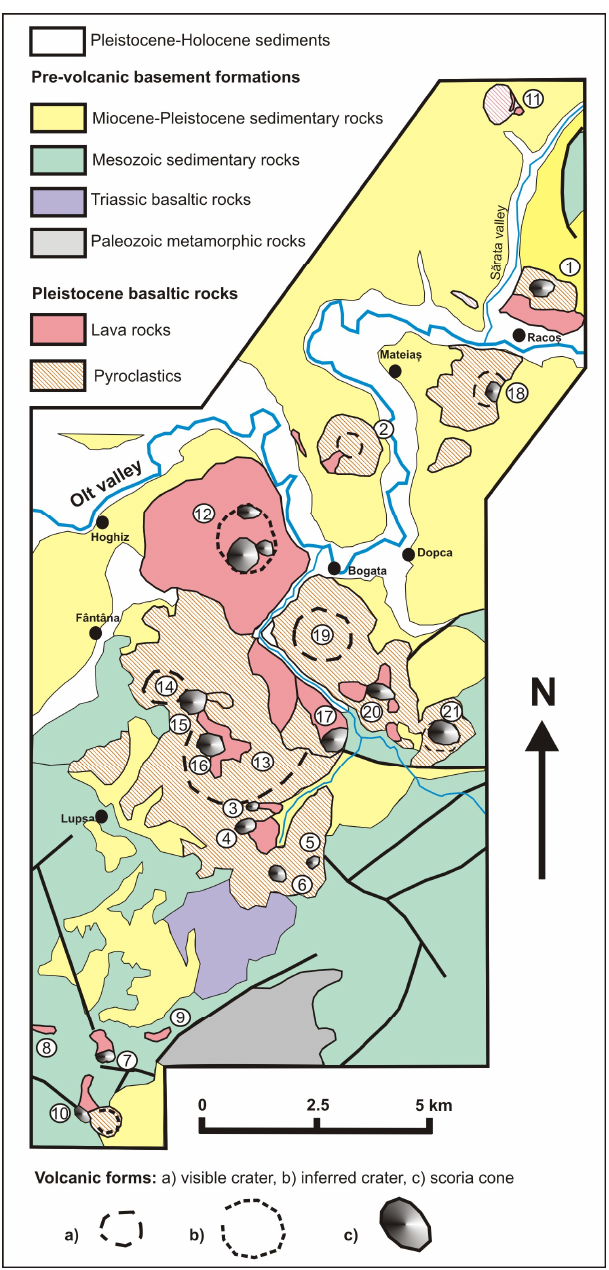
Figure 13. Volcanological map of the Perșani Mountains alkali basaltic volcanic field (acc. to Seghedi et al., 2016, simplified) showing the recognized volcanic centers: 1. Racoș; 2. Turzun; 3. Trestia-Nord; 4. Trestia-West; 5. Trestia-East; 6. Trestia-South; 7. Comana; 8. Comana-West; 9. Comana-East; 10. Comana-South; 11. Sărata; 12. Măguricea; 13. Bârc; 14. Fântâna; 15. Gruiu; 16. Gruiu- Mic; 17. 636; 18. Mateiaș; 19. Bogata; 20. Dîlma-West; 21. Pietrele.